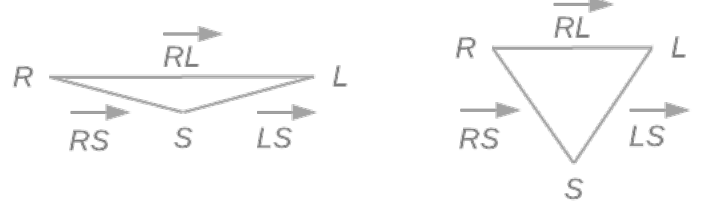
Figure 9. Scapular retraction (https://workoutsprograms.com/ejercicios/retraccion-escapular).